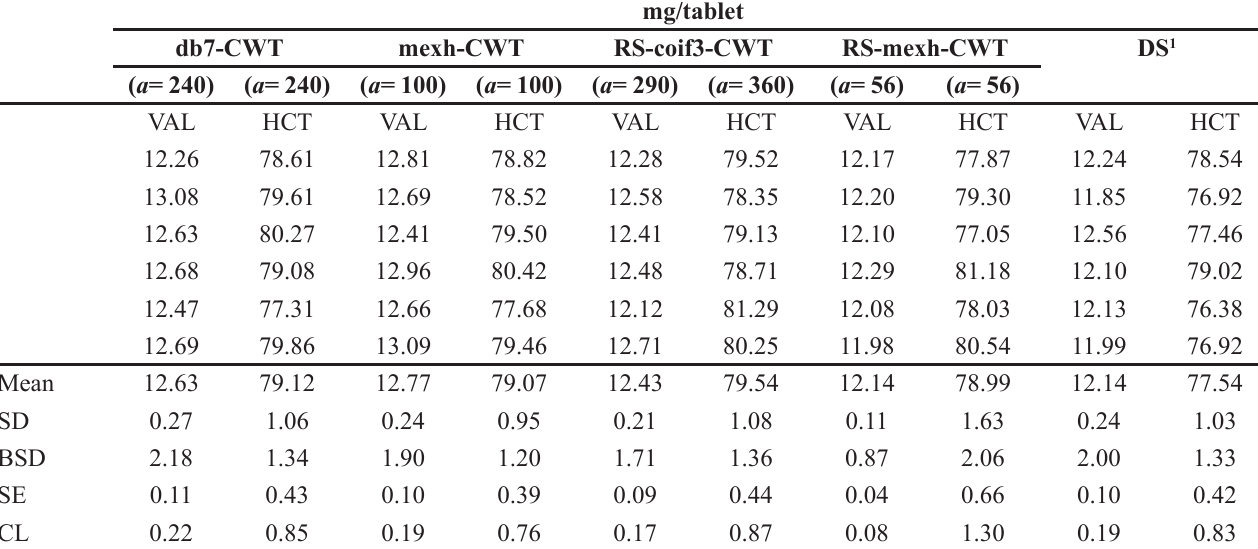
TABLE III - Determination results of VAL and HCT in tablets by CWT methods